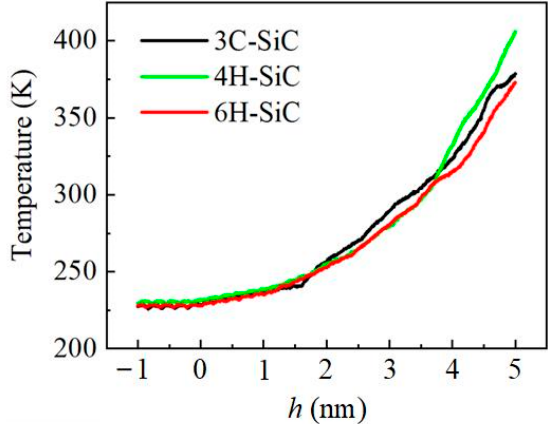
Figure 12. Temperature of SiC polytypes during indentation.